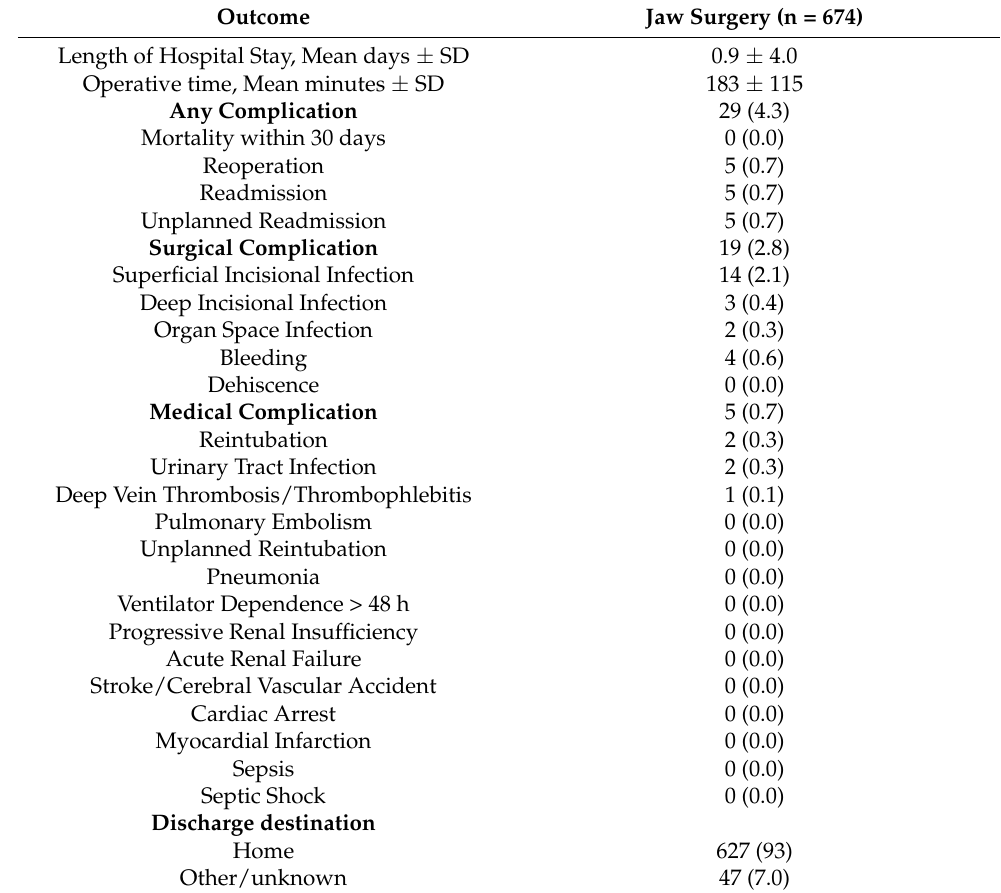
Table 4. Operative and postoperative outcomes following jaw surgery. Reported as n (%), unless otherwise stated.